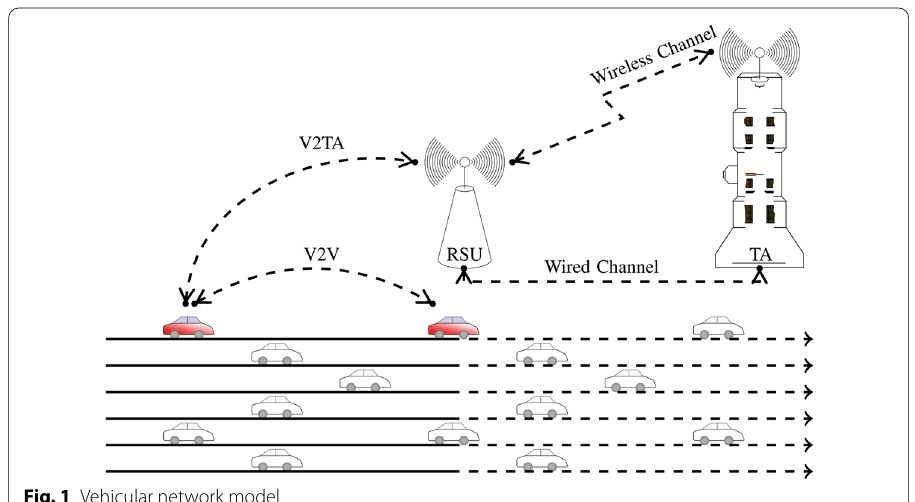
Fig. 1 Vehicular network